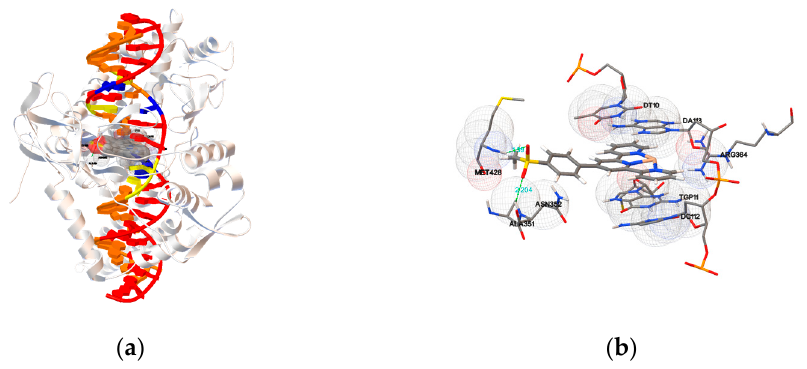
Figure 11. ( a ) Molecular docking models and ( b ) enlarged view of 2f in the active site of DNA–Topo I complex (PDB ID: 1SC7). The formed hydrogen bond and distance have been marked .